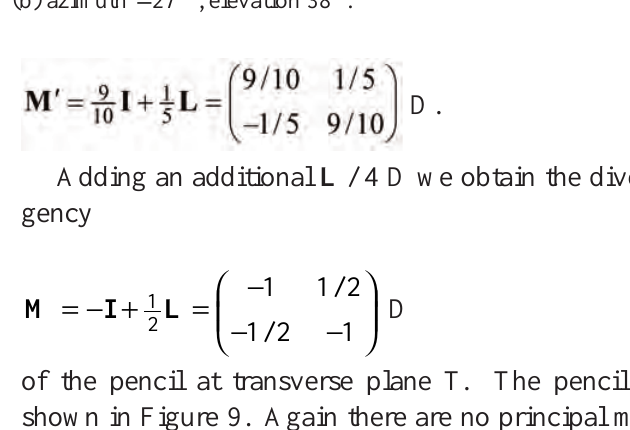
Figure 6 A pencil with divergency 2/ LJM += D at T. The rotation of the principal meridional planes and the rotation and displacement of the focal lines evident in Figure 5 contines here. (b) azimuth °− 64 27 °− 64 , elevation 38 °− 64